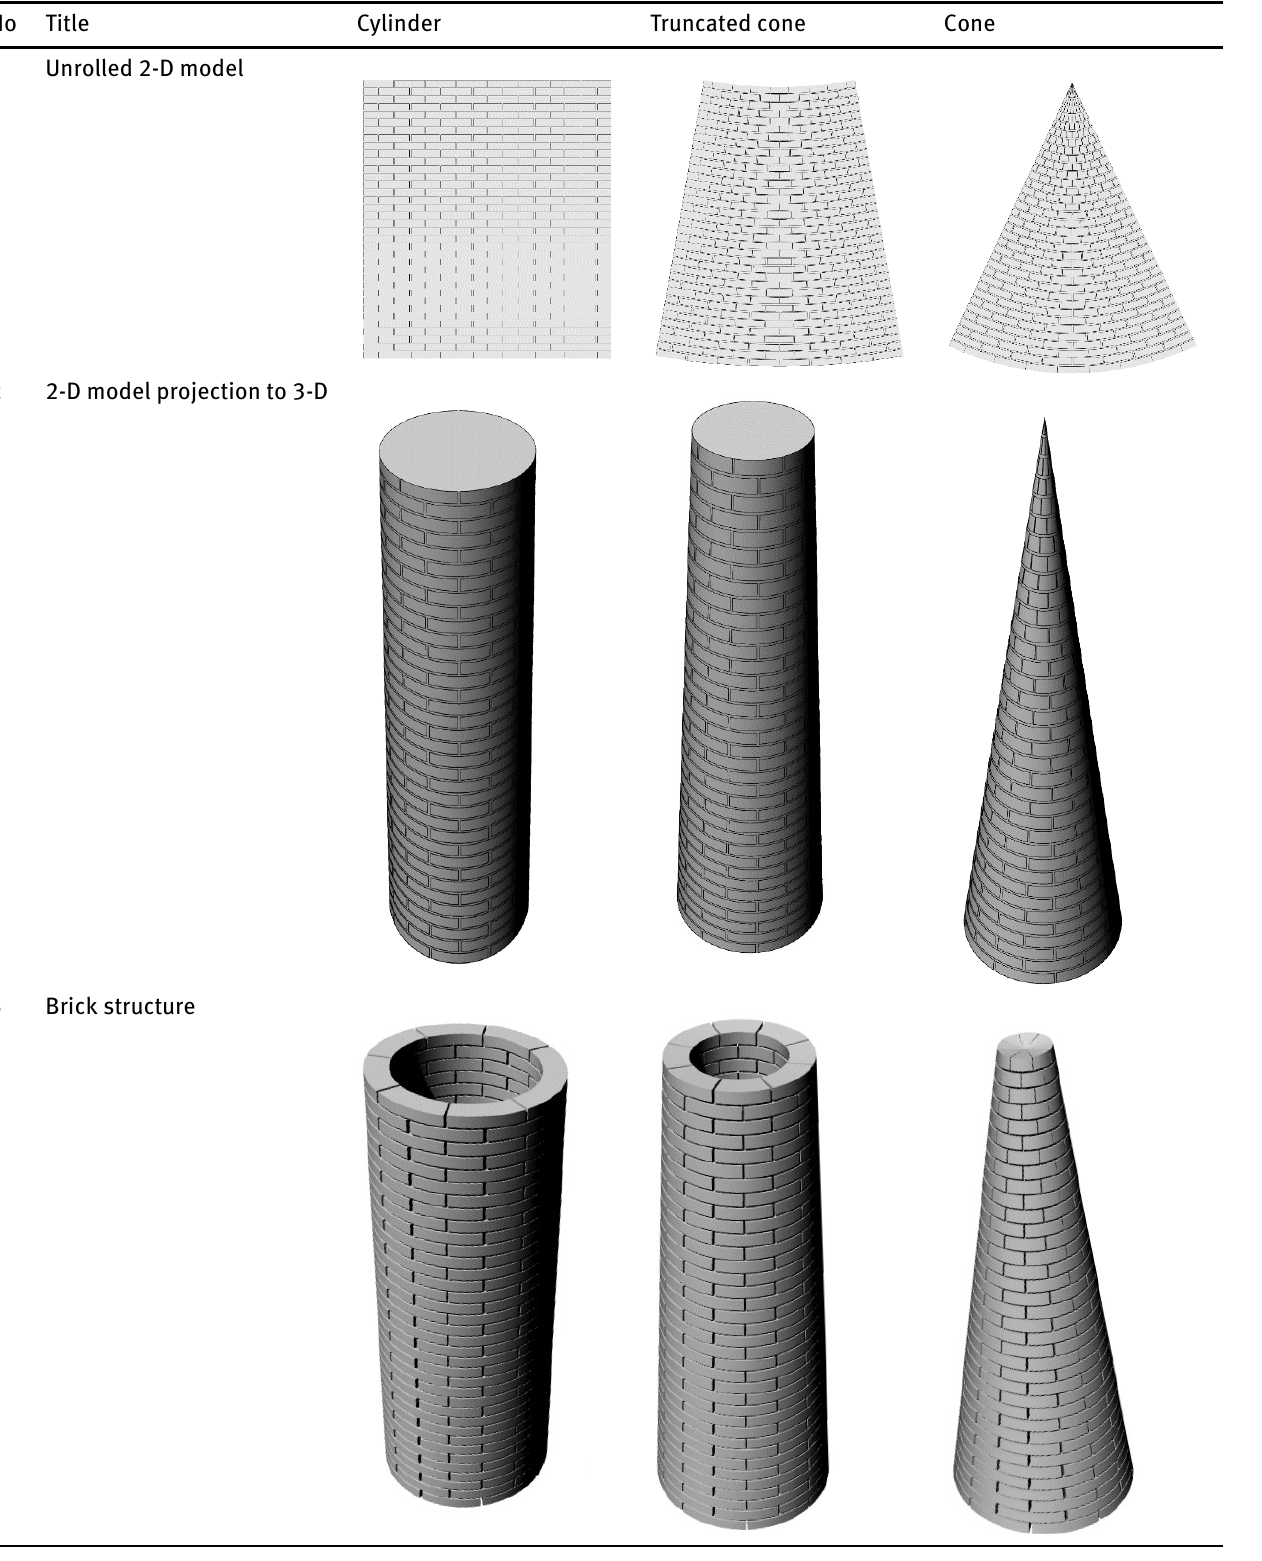
Table 1: The change process in simple brickwork pattern modeled on different 3-D shapes (cylinder, truncated cone, and cone).